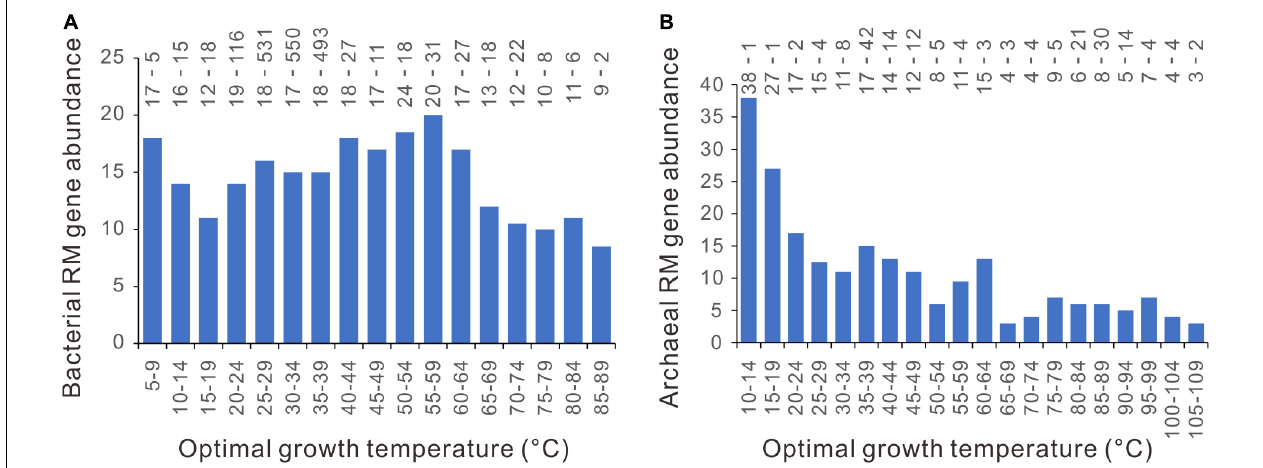
FIGURE 8 | Relationships between restriction-modification (RM) gene abundance and optimal growth temperature. (A) bacteria. (B) archaea. Because median values are less sensitive to extreme outliers than the mean values, we created the column charts using the median value of each Topt range. The mean value and the number of genomes of each bin (separated by a hyphen) are shown at the top of each chart.